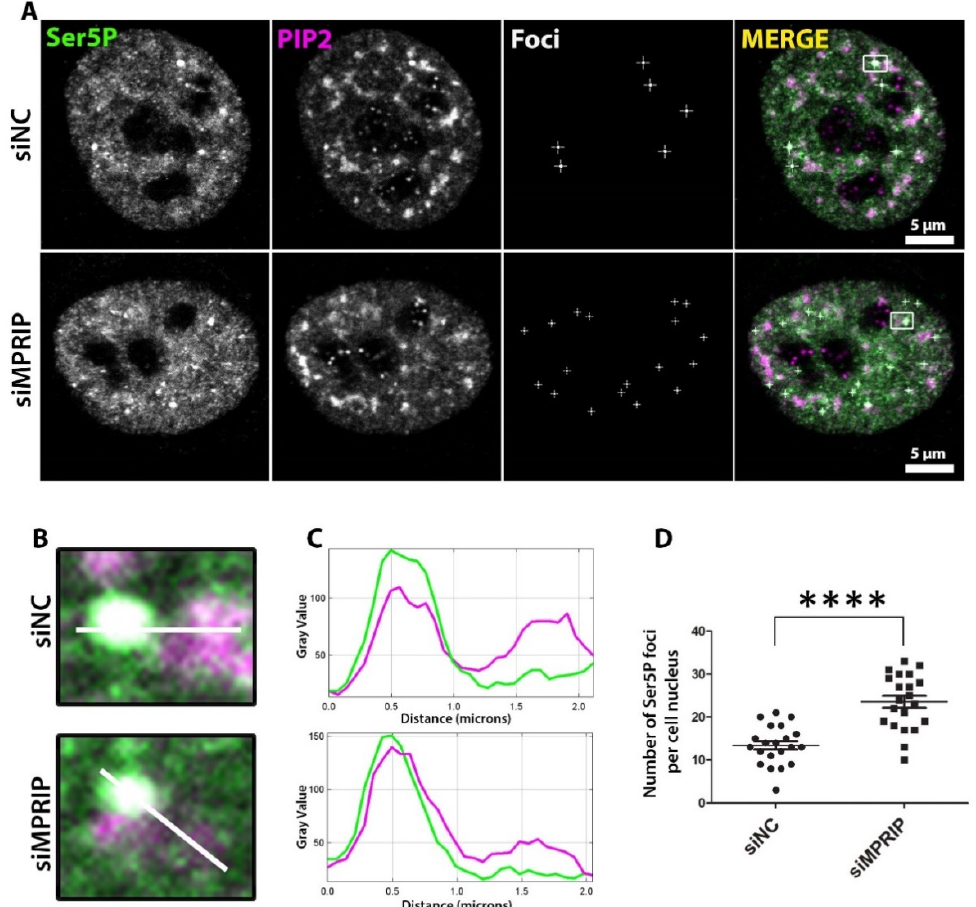
Figure 3. The number of Ser5P-CTD foci increase upon MPRIP depletion in cell nuclei. ( A ) Immunofluorescence labeling experiment on U2OS cells showing the Ser5P-CTD foci in control ( siNC —small interfering Negative Control RNAs) and MPRIP-depleted ( siMPRIP —small interfering MPRIP RNAs) nuclei. Scale bars represent 5 µm. ( B ) Zoomed views of foci that are marked by a white rectangle in the “Merge” images. The white lines on the zoomed views represent the regions for the intensity plots on ( C ) where the upper plot corresponds to the intensities of siNC and lower, to siMPRIP. ( D ) The dot plot shows the number of Ser5P-CTD foci per cell nucleus of siNC and siMPRIP. The quadruple asterisks “****” correspond to a significance level of p ≤ 0.0001. n = 3.